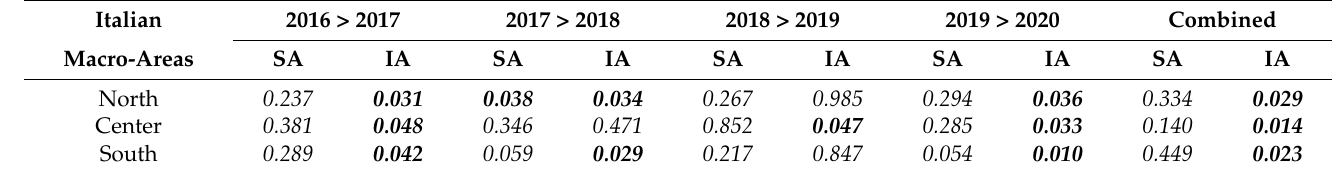
Table 5. Stochastic ordering: evaluation of a monotone decreasing trend over